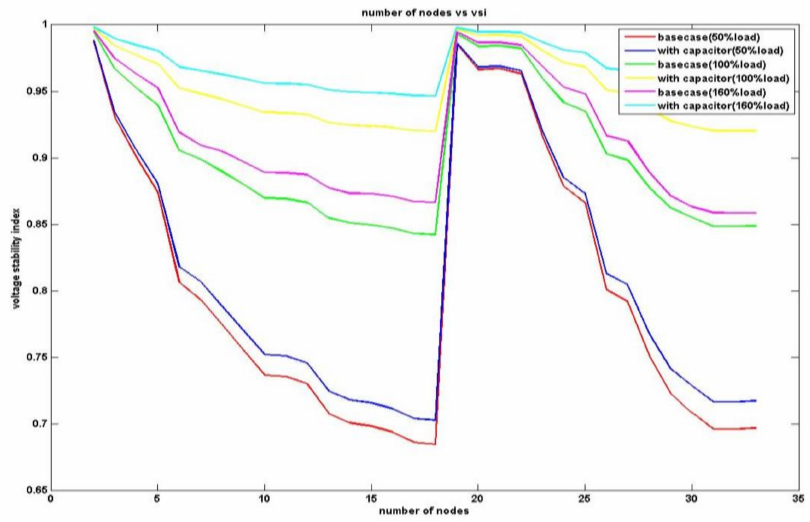
Figure 4. VSI vs. node number before and after